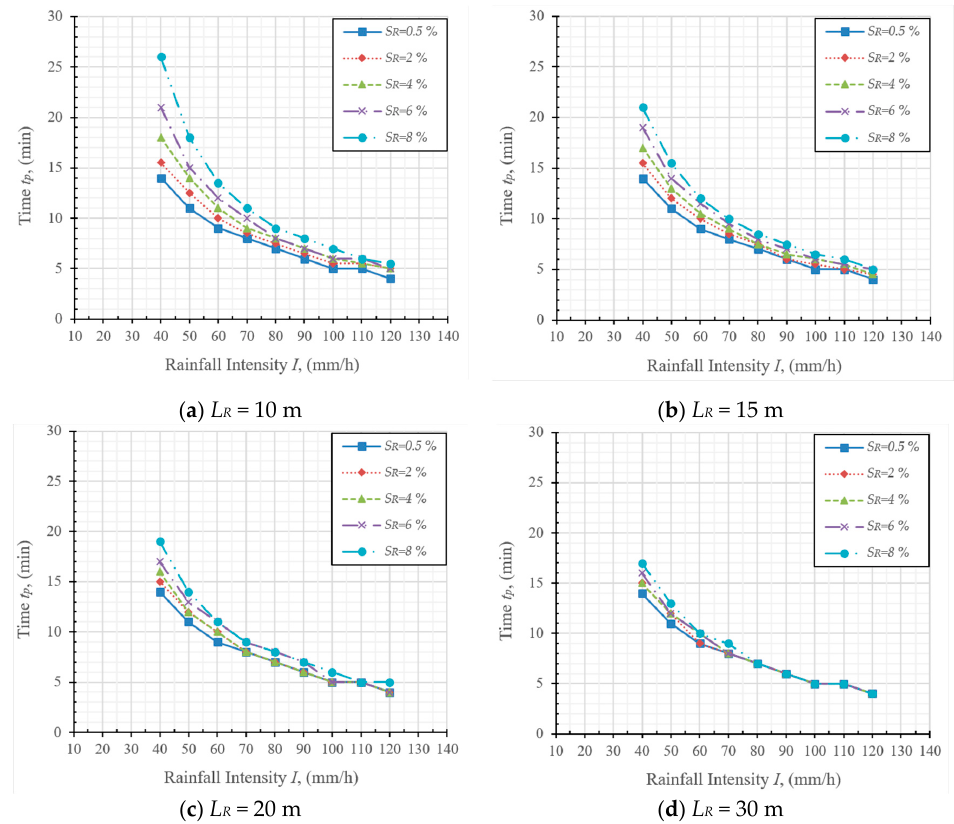
Figure 6. Relationship between the time taken for the water flow over the PFC pavement surface ( t p ) and rainfall intensity ( I ) with different slope ( S R )